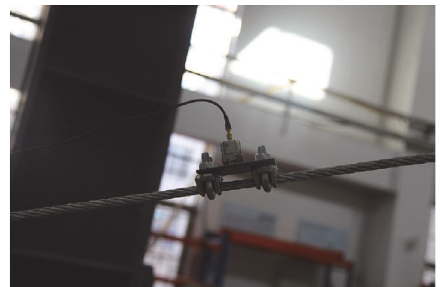
Figure 8: Installation of the accelerometer.